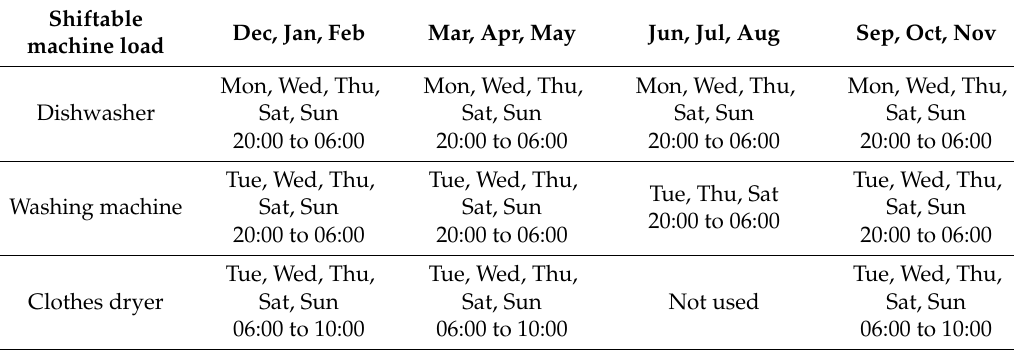
Table 2. The seasonal operation time windows of the shiftable machine loads.